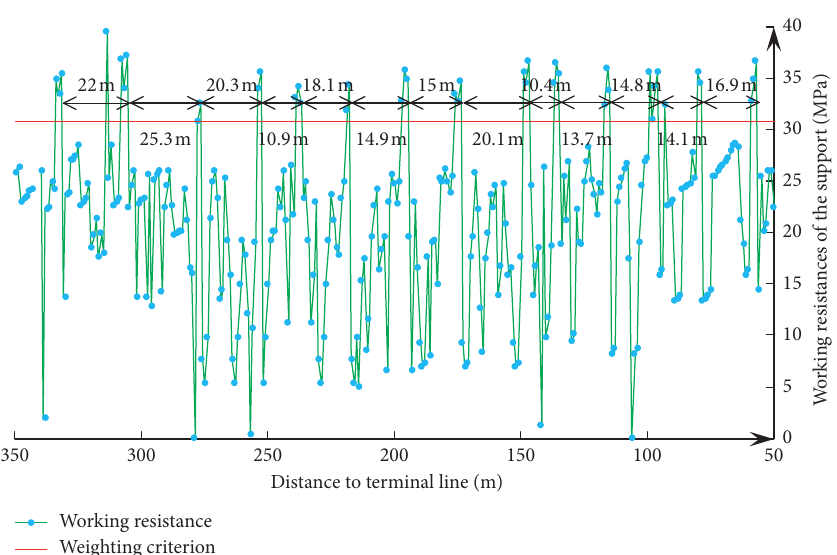
Figure 8: Working resistance curve of the support during the mining of the #3-1 coal Figure 9. The mechanical parameters of the coal strata are determined by mechanical tests, as shown in Table 2. A multikey strata structure exists in the roof of the #2 coal seam. According to the definitions of PKS and SKS, a medium coarse sandstone stratum with a thickness of 7.5 m is the SKS closest to the stope, and a medium sandstone stratum with a thickness of 10.82 m is the PKS. The regular circulation footage of the working face is 0.8 m. The working face is equipped with ZY8500/20/42-type supports.